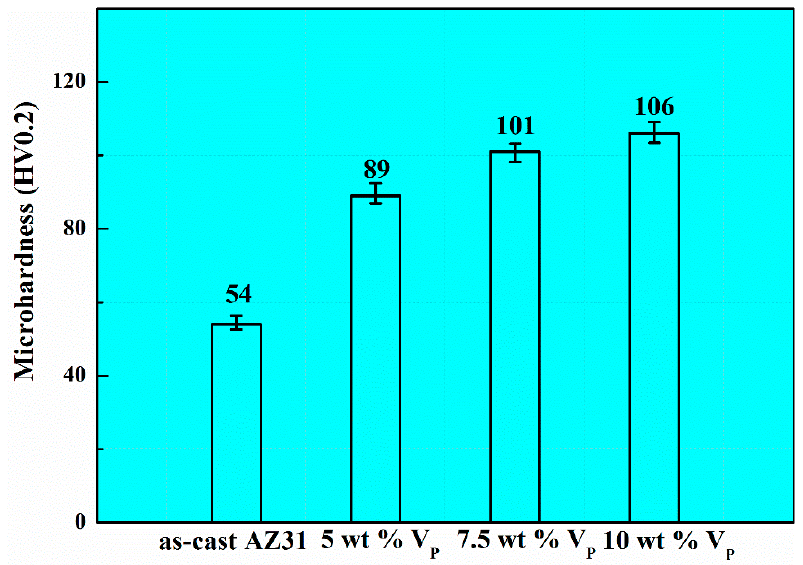
Figure 13. The microhardness of as ‐ cast AZ31 Mg alloy and AZ31 ‐ X wt % V P (X = 5, 7.5, 10) compo ‐ sites.